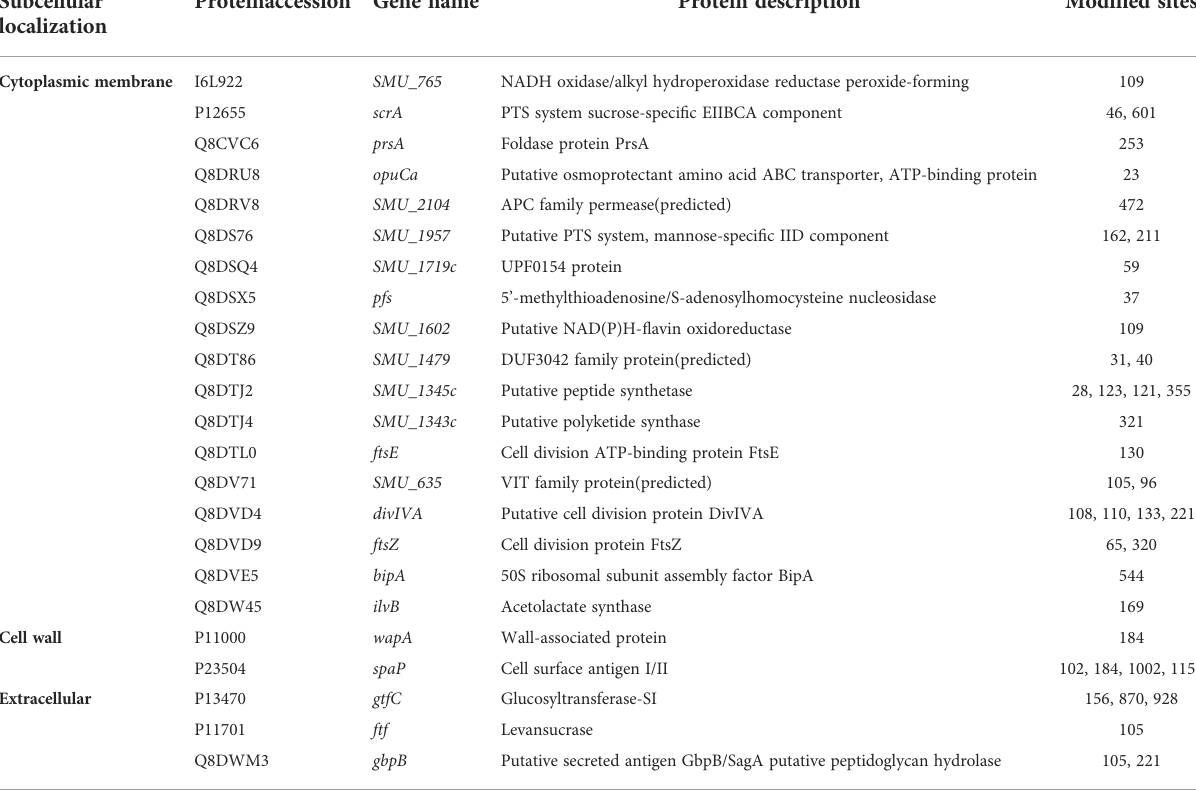
TABLE 1 The malonylated proteins that are located in the cytoplasmic membrane, cell wall or extracellular. Subcellular